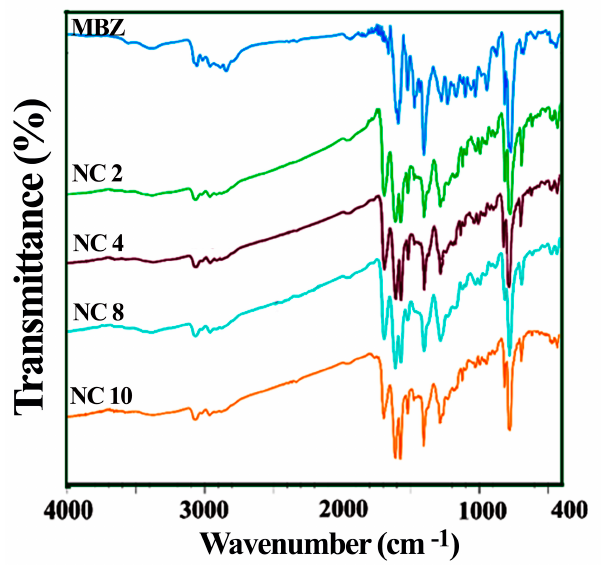
Figure 4. FT-IR spectra of MBZ, PBZ/PDA/CeO 2 NC 2, PBZ/PDA/CeO 2 NC 4, PBZ/PDA/CeO 2 NC 8, and PBZ/PDA/CeO 2 NC 10.